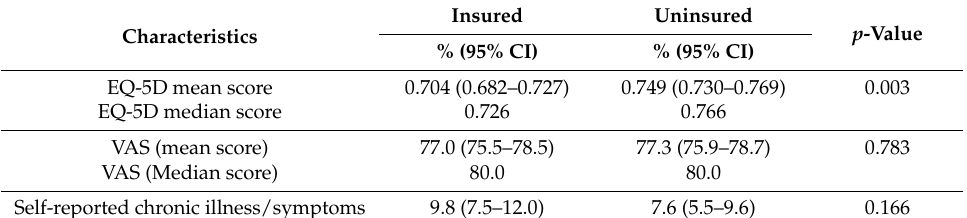
Table 3. Health status (EQ-5D and VAS score) and self-reported illness between insured and uninsured.